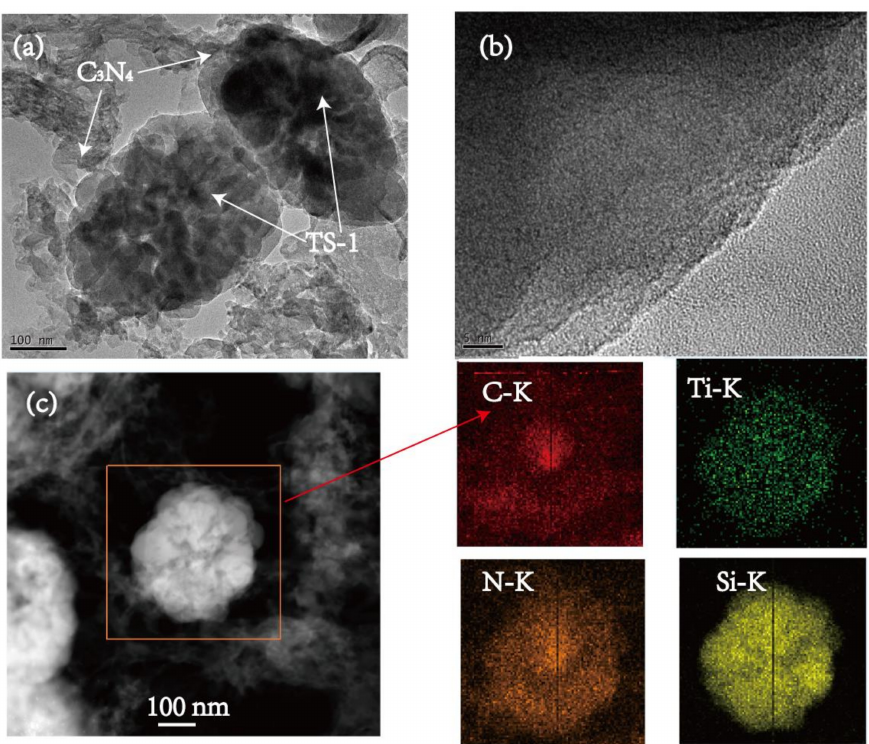
Figure 4. TEM ( a ) and HRTEM ( b ) images of TC-B. ( c ) Element mapping images of the boxed area are shown for C-K, N-K, Ti-K and